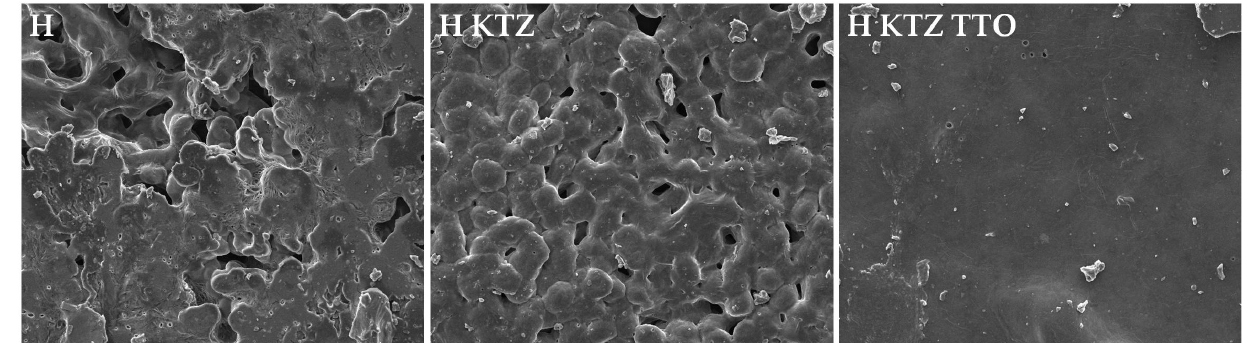
Figure 1. The SEM images of PLU ® F ‐ 127 hydrogels: placebo (H); with KTZ (H KTZ); and with KTZ and TTO (H KTZ TTO), magnification 1000×.